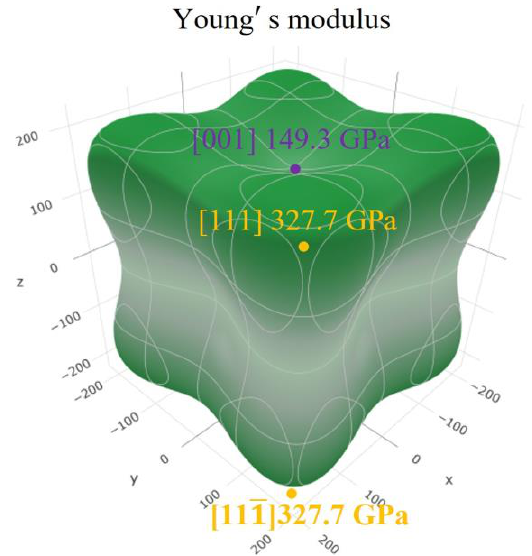
Figure 8. Three- dimensional orientation map of FeAl Young’s modulus. Figure 8. Three-dimensional orientation map of FeAl Young’s